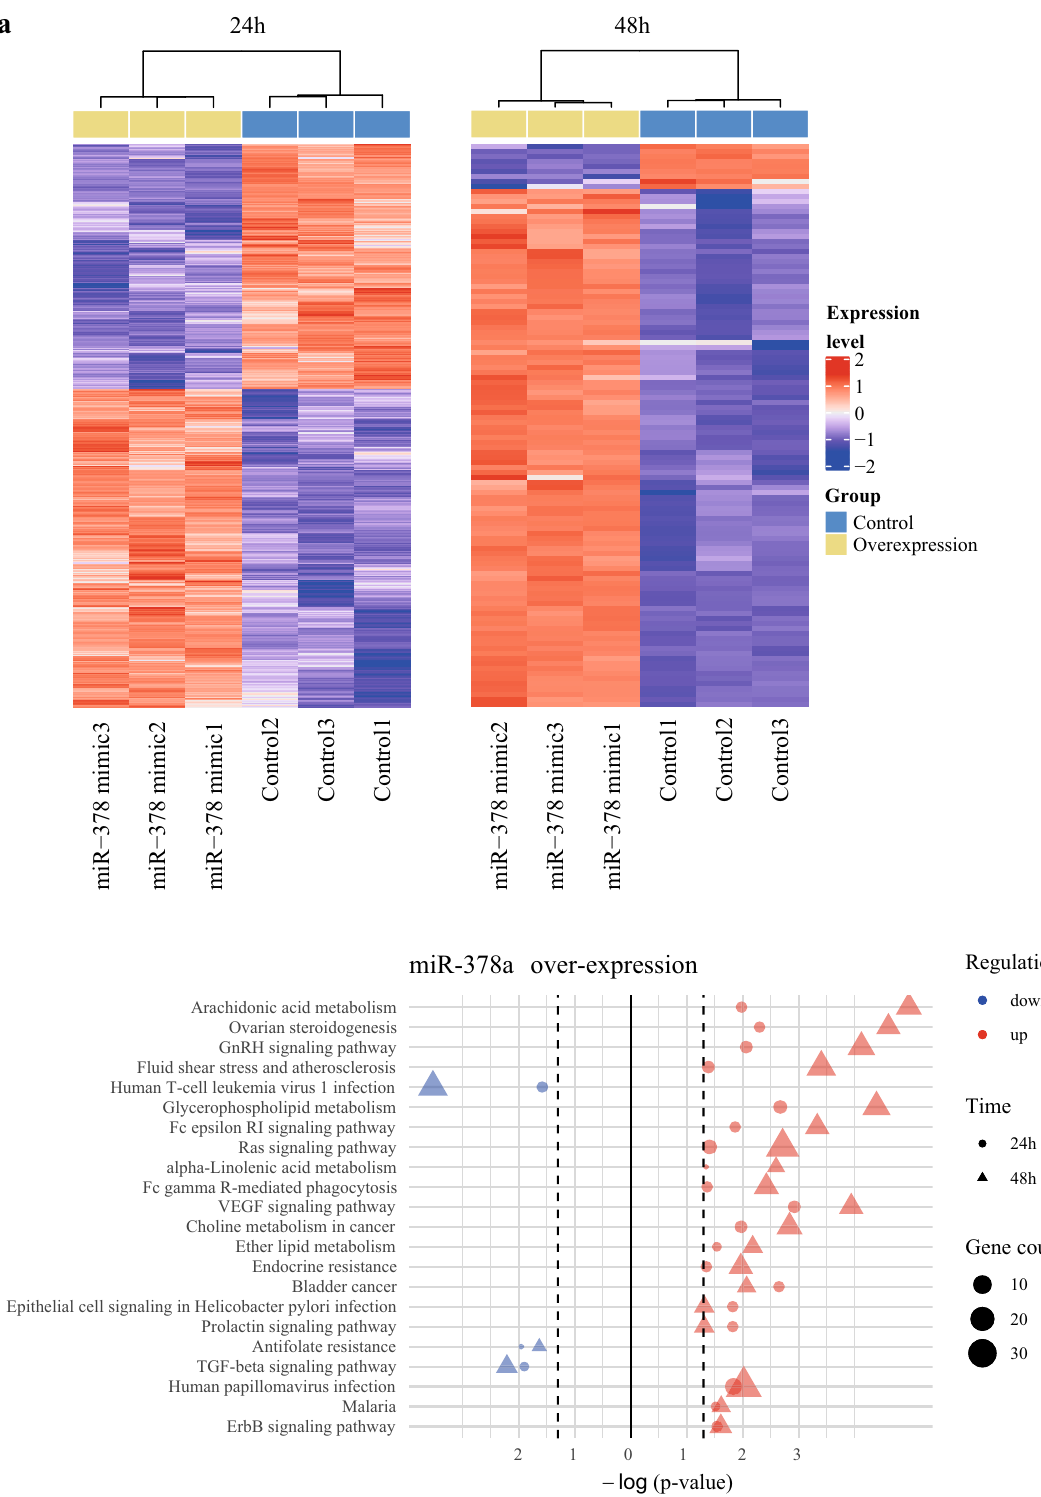
Figure 3. The gene expression profiles in miR-378a overexpressed NHEK cells. ( a ) Heatmap of DEGs in keratinocytes over-expressing miR-378a for 24 h (1233 genes; left) and 48 h (112 genes with |log(fold- change)| > 1.5; right). The heatmaps were drawn using ComplexHeatmap R package. ( b ) The top overlapped KEGG pathways associated with up- and down-regulated genes at both 24 h and 48 h post-transfection of miR- 378a mimic. The figures were drawn using tidyverse R